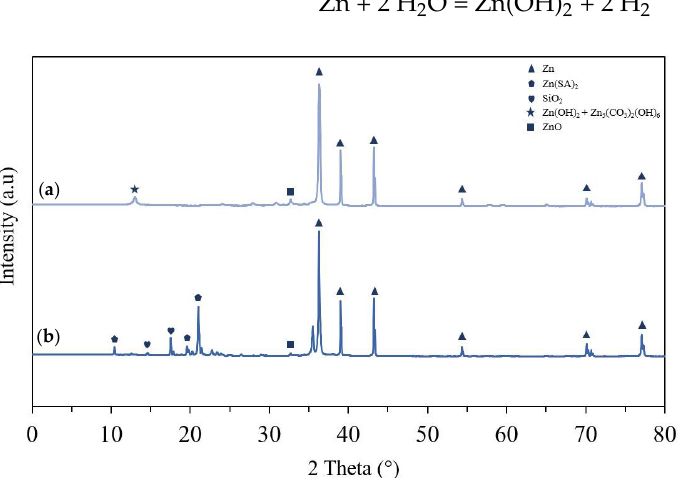
Figure 14. XRD patterns of humidity samples after 1000 h ( a ) uncoated sample and ( b ) hydrophobic sample.